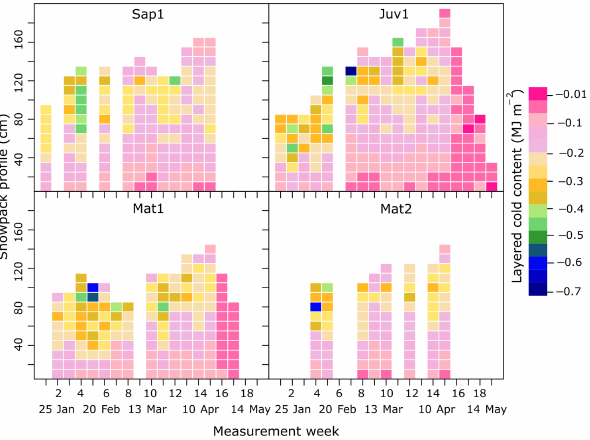
Figure 4. Weekly 10cm CC observations from snowpit surveys. The colour bar indicates CC values in MJm − 2 .